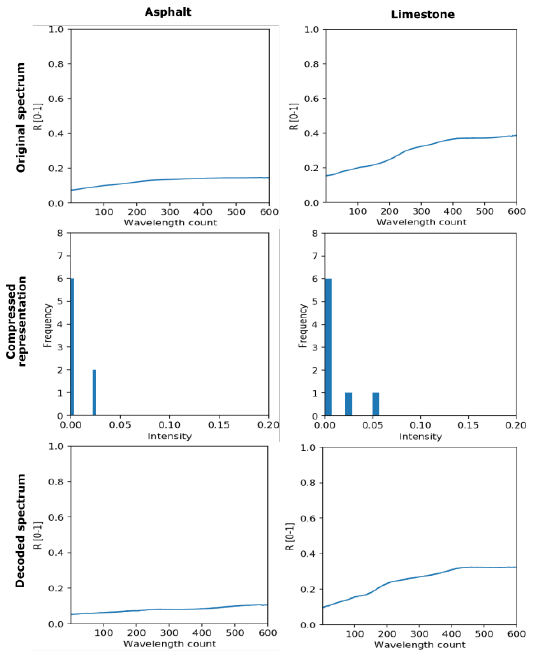
Figure 7. Two examples of the original spectra and their corre- sponding decompression in addition to the compressed represen- tation visualized as a vector in the spectral range of 350–949 nm for the two material classes Asphalt and Limestone